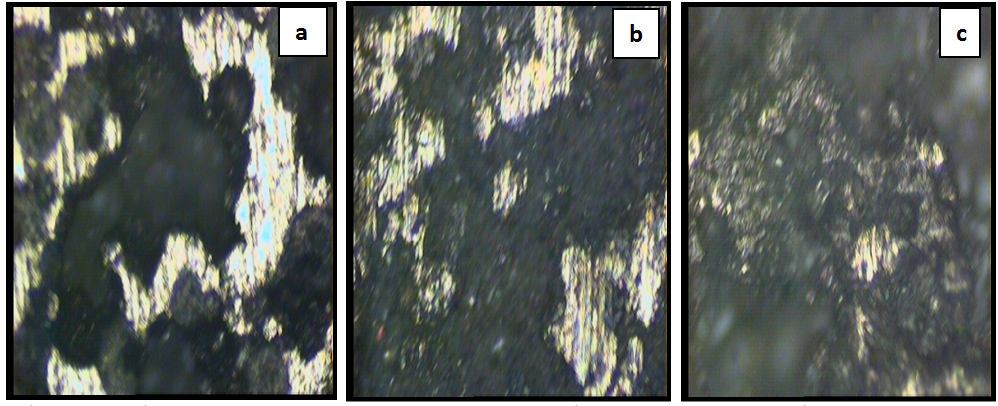
Fig.6: Coating layer after Laser treatment at different pulse energies (a) 400 mJ, (b) 460 mJ and (c) 500 mJ.